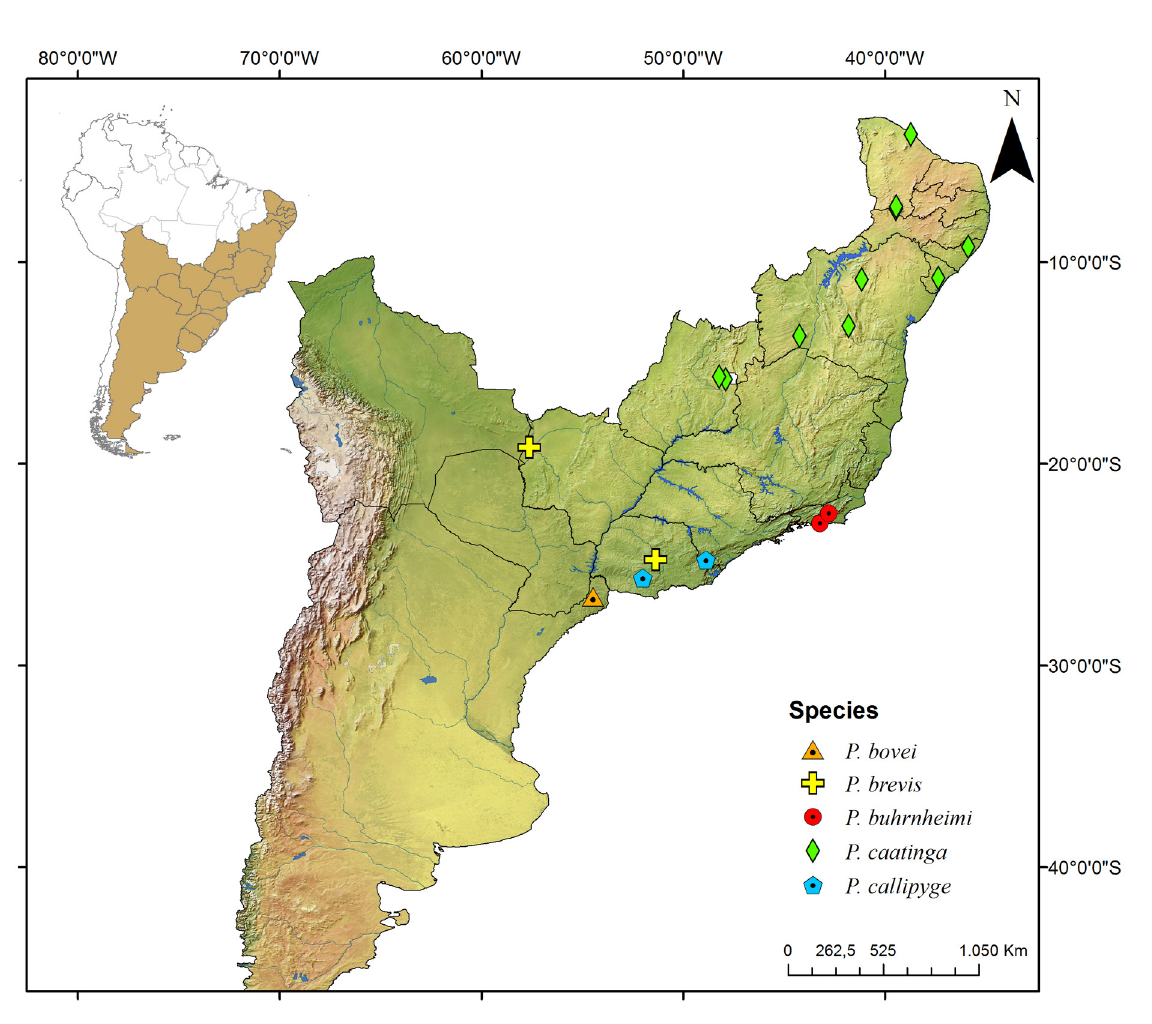
Fig. 181. Distribution map of the species Pseudonannolene bovei Silvestri, 1895, P. brevis Silvestri, 1902, P. buhrnheimi Schubart, 1960, P. caatinga Iniesta & Ferreira, 2014, and P. callipyge Brölemann,